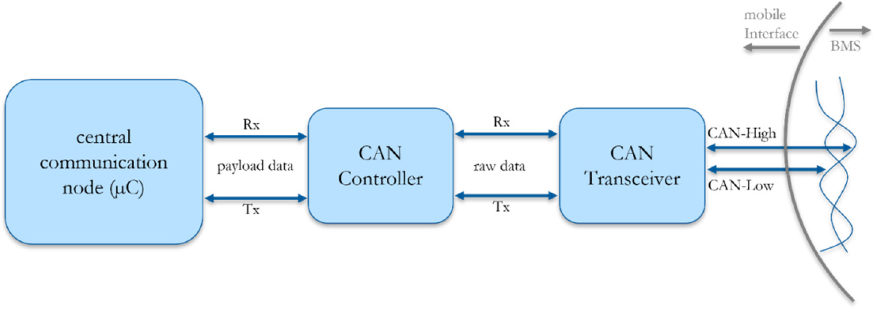
Figure 4. Physical data connection to BMS channel: data that are sent on the CAN-H and CAN-L line of the BMS are read into the CAN-Transceiver and forwarded to the CAN-Controller, which extracts the payload data from the complete data stream to be input into the